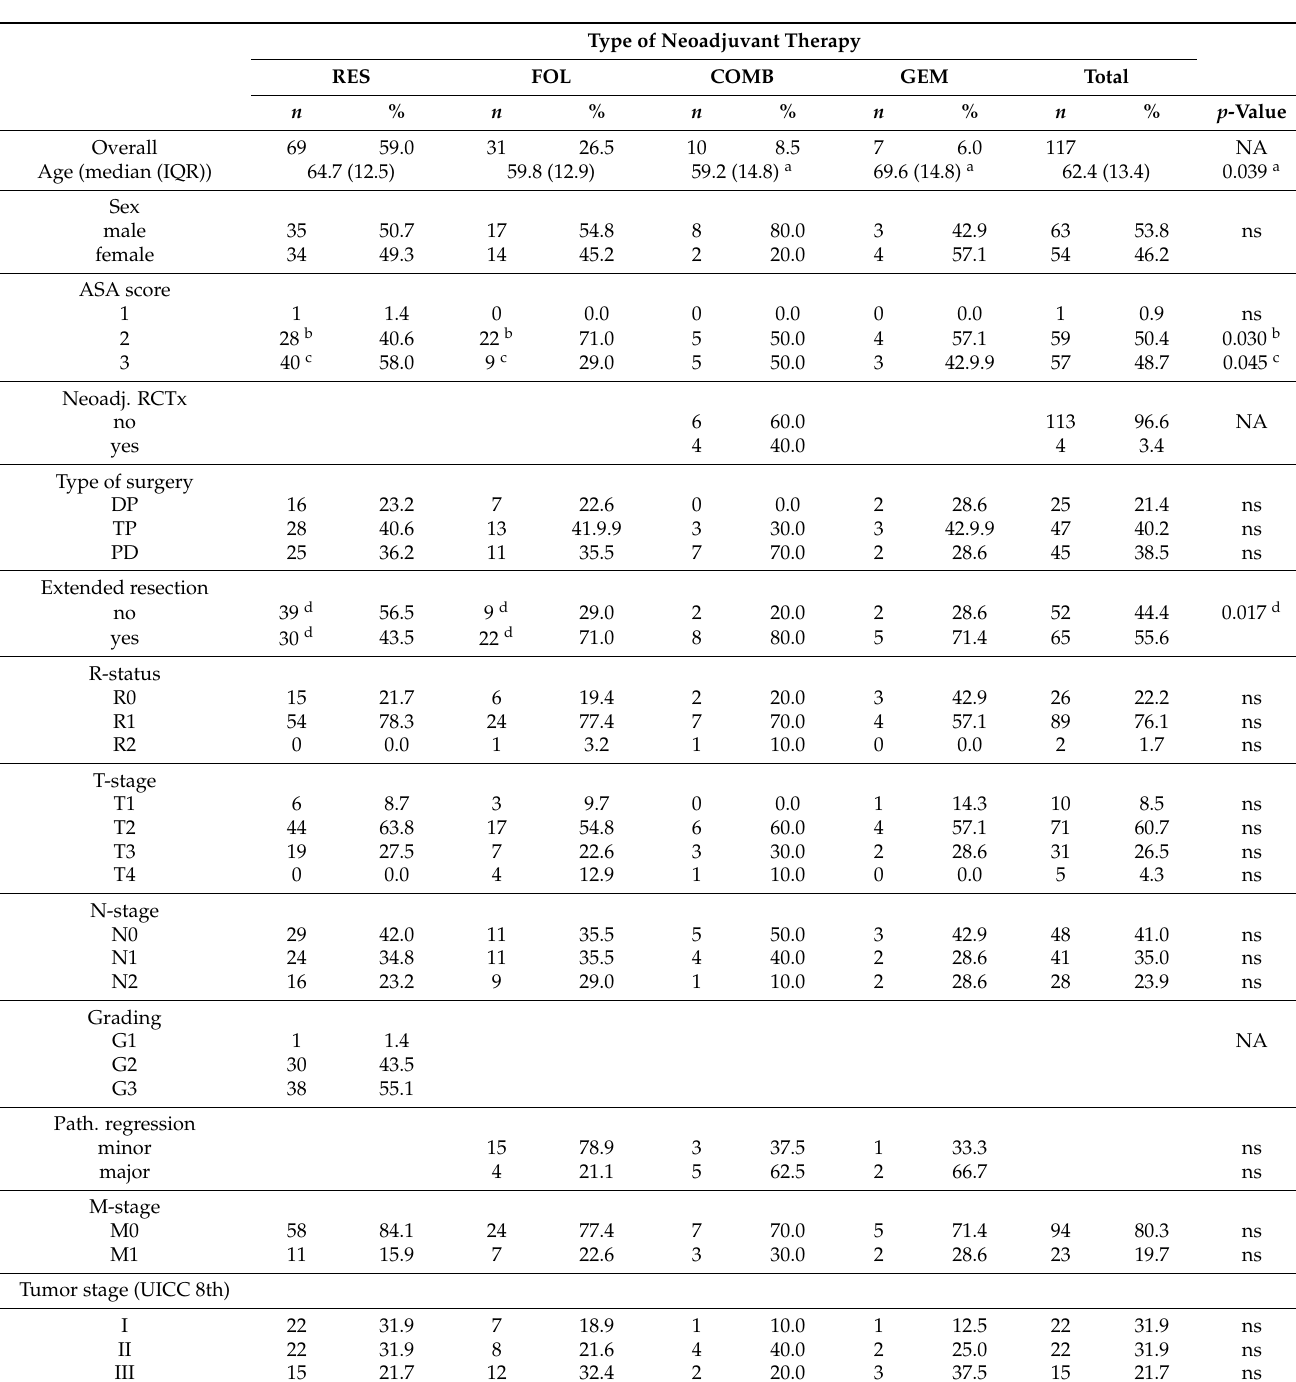
Table 1. Comparison of patient